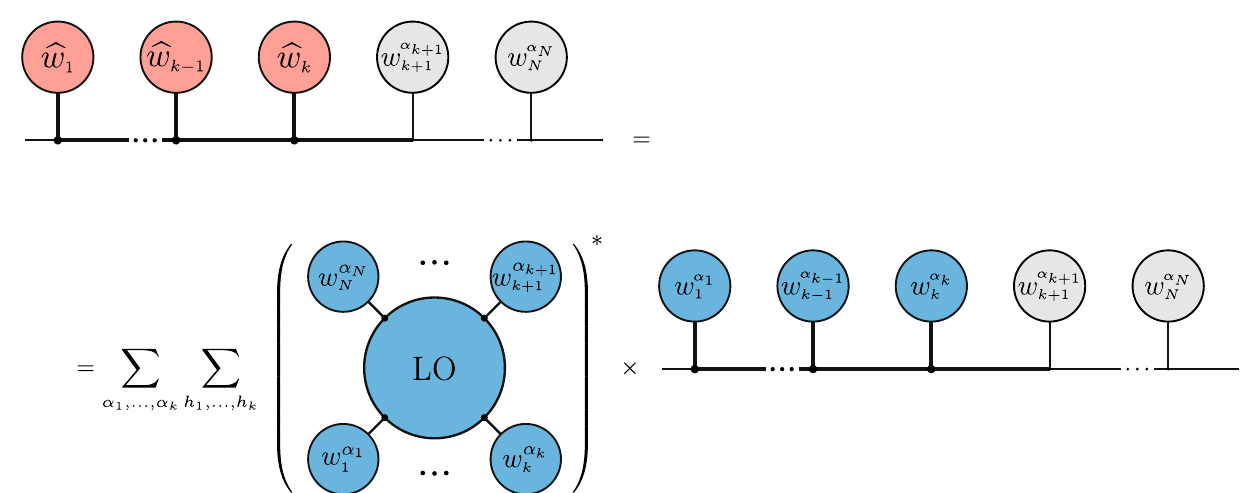
topologically equivalent diagrams with the same undressed segments { S α k + 1 ,..., S α N } is merged in a single open loop. See (70) and k + 1 N